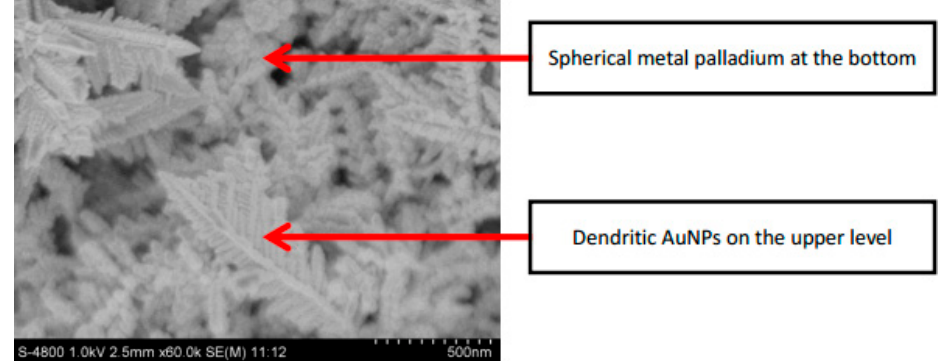
Figure 4. SEM images of Pd ‐ AuNPs composite sensing film with magnification of 60K.